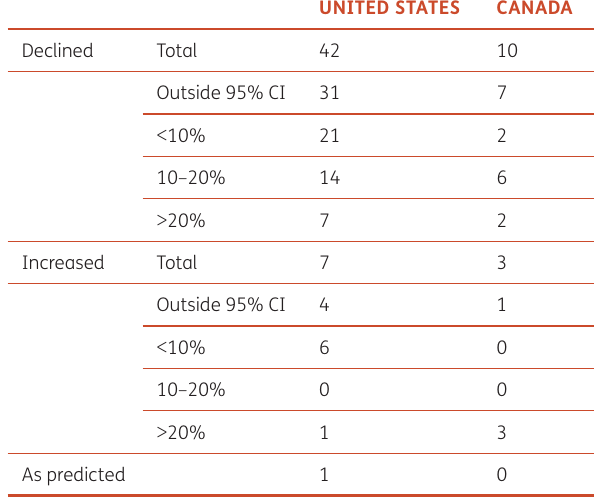
Table 1 Number of states and provinces showing declines and increases in number of CBC counts in 2020 compared with that predicted based on trends of the previous 10 years. Results by state are in Supplemental Tables 1 and